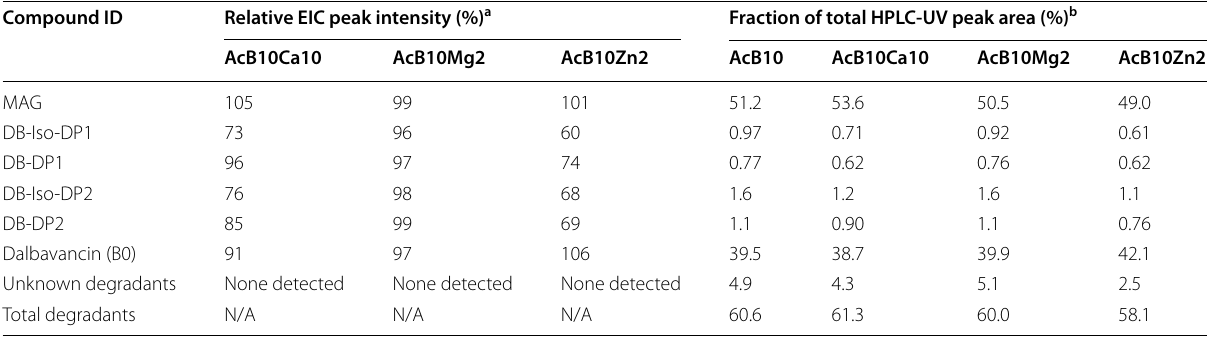
a Levels of degradation products are expressed relative to their levels in acetate buffer without metal ions b Levels of degradation products are expressed as the area under their HPLC peak as a percentage of the total peak